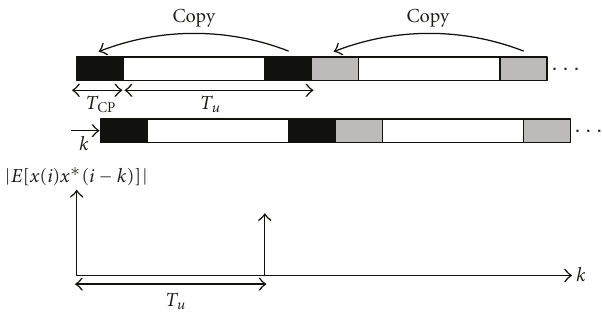
Figure 2: Correlation on a CP-OFDM signal.